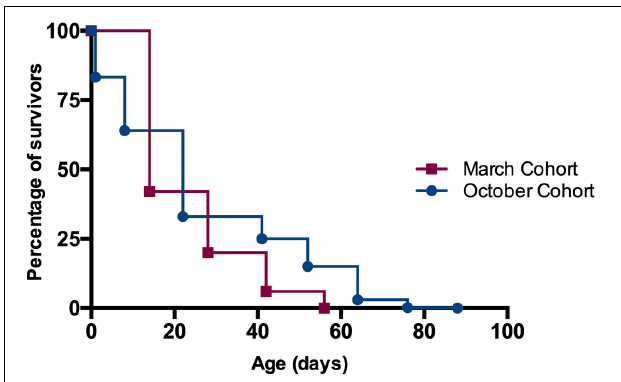
FIGURE 3 | Monitoring the longevity of worker bees in different months in PR. Cohort of 1-day old bees introduced in October had significantly greater